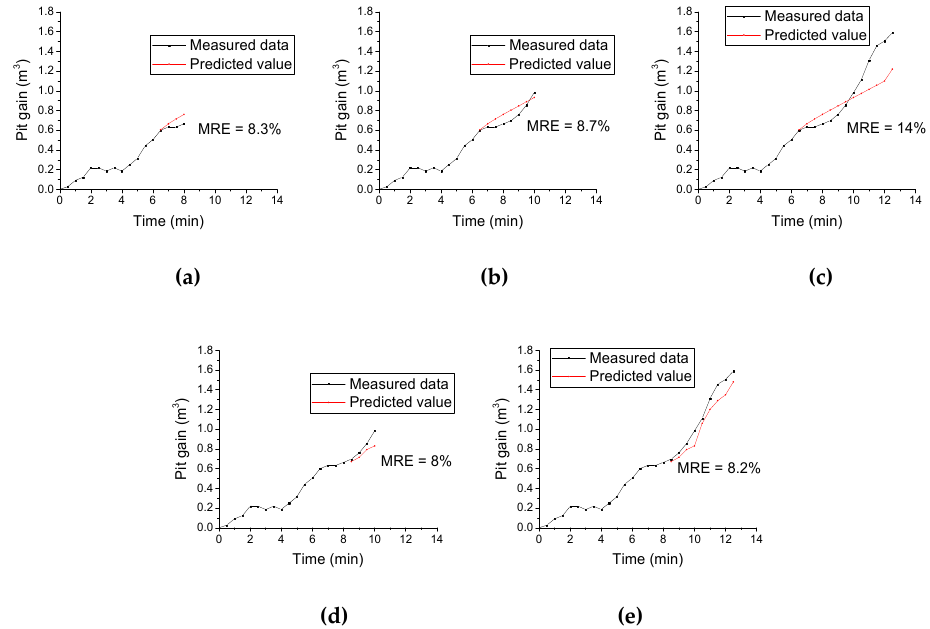
Figure 9. Measured data and predicted values of pit gain vs. time in different periods: ( a ) prediction period 6.5–8 min, ( b ) prediction period 6.5–10 min, ( c ) prediction period 6.5–12.5 min, ( d ) prediction period 8.5–10 min, and ( e ) prediction period 8.5–12.5 min.